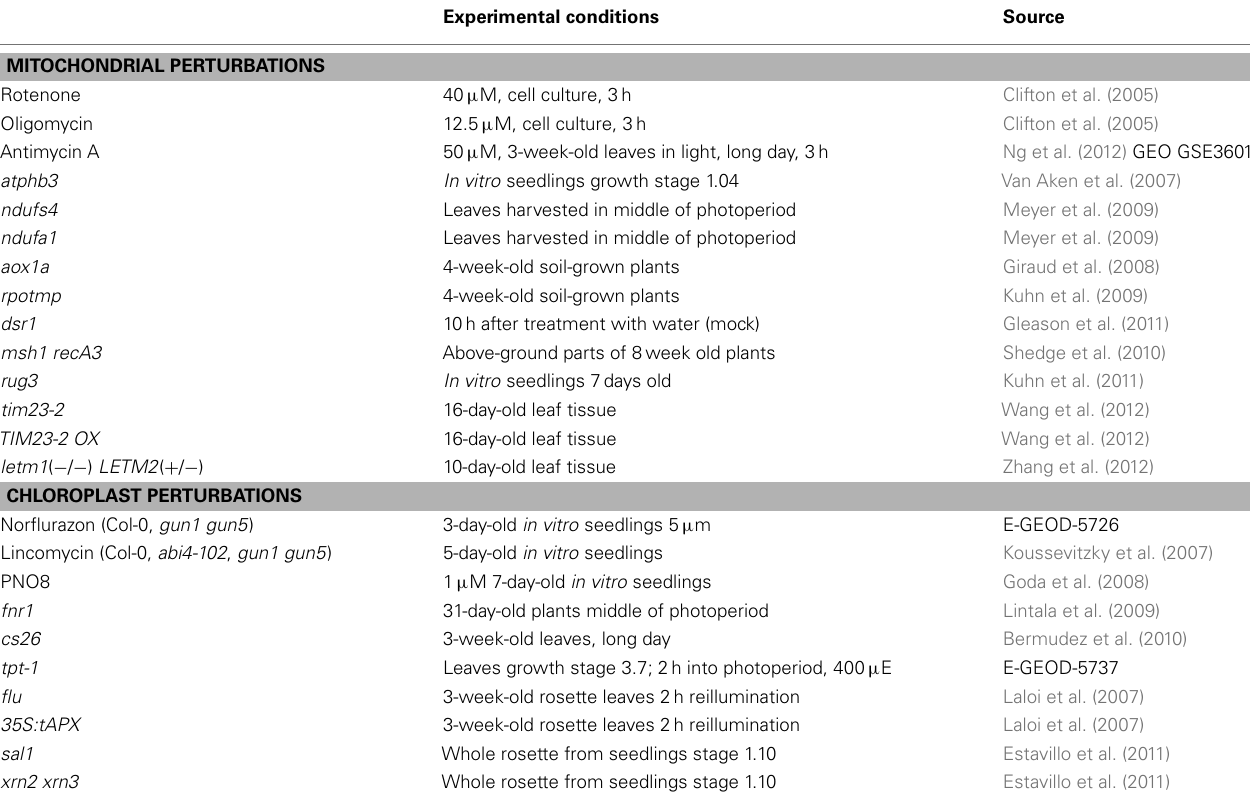
Table 1 | List of microarray experiments related to mitochondrial and chloroplast perturbations used in this study.